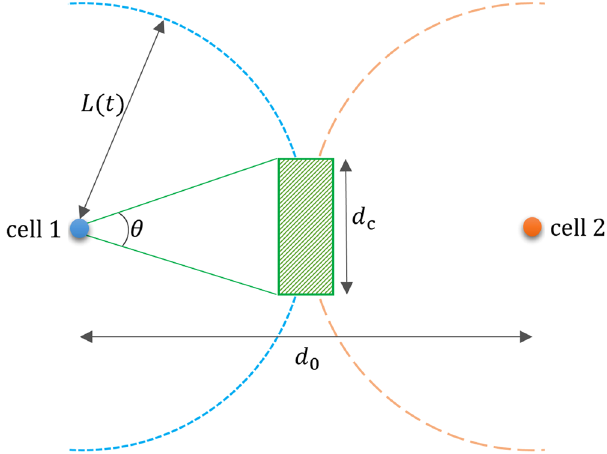
Figure 6. An illustration of the calculation of the probability for two cells to be a distance d c or less apart at a time t when they perform random walks from initial positions separated by a distance d 0 . Blue and orange dots show the initial positions of the cells. After a time t , each cell is located at a distance L from its original position at some point on the circle shown short-dashed (red) and long-dashed (blue), respectively. To be within a distance less than d c , the cells need to be anywhere in the green rectangular